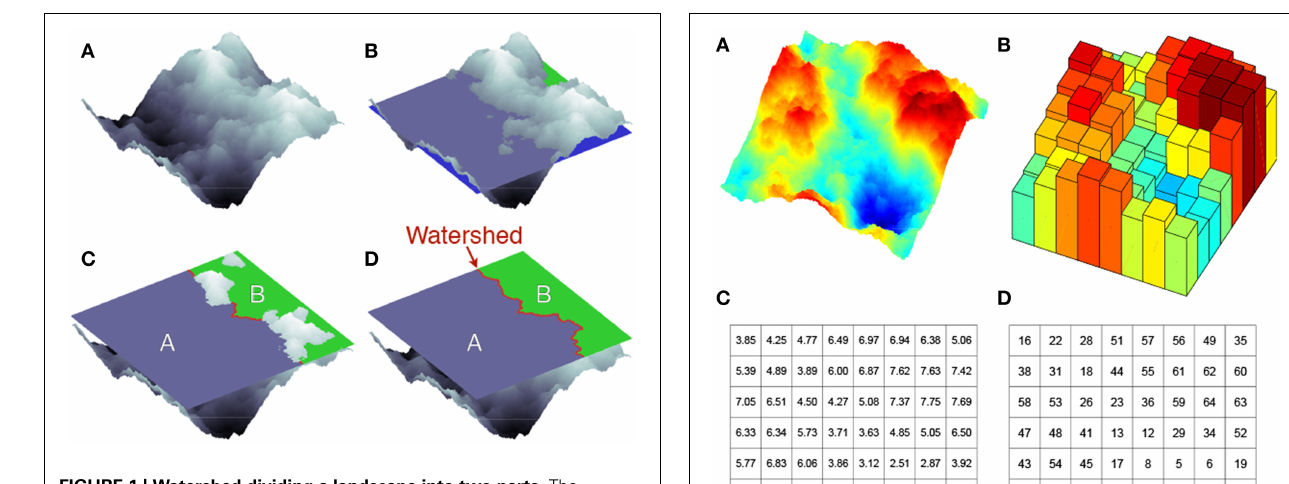
FIGURE 1 | Watershed dividing a landscape into two parts. The landscape (A) is flooded from the valleys such that all regions lower than a certain height are covered with water (B) . As the water level rises, lakes merge under the constraint that no lake can connect two predefined opposite boundaries of the landscape (C) . In this example, we have taken the lower-left and the upper-right boundaries. Thus, a watershed line emerges separating the two final lakes (D) . These lakes (A and B) are the drainage basins of this landscape.